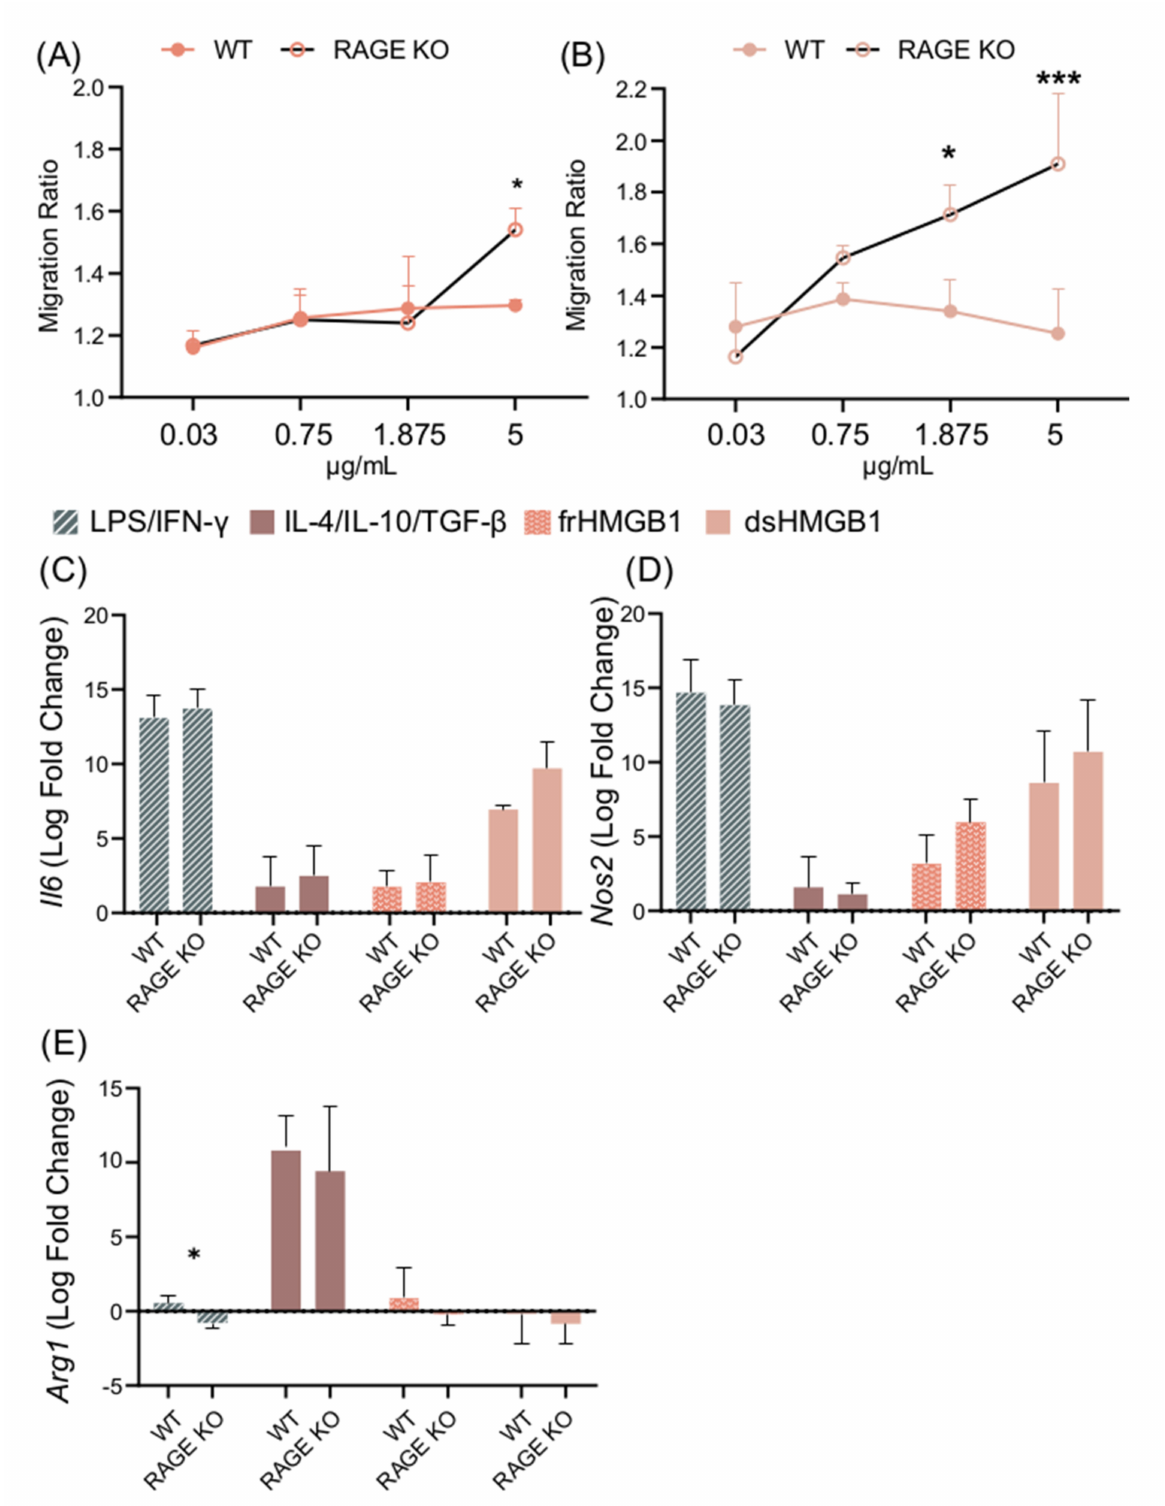
Figure 7. dsHMGB1 induces migration in RAGE KO BMDMs. Migration ratio for a dose titration with ( A ) frHMGB1 and ( B ) dsHMGB1 in RAGE KO and WT BMDMs. Gene expression of ( C ) Il6 , ( D ) Nos2 , and ( E ) Arg1 in WT and RAGE KO BMDMs treated with PBS (negative control), LPS/IFN- γ , IL-4/IL-10/TGF- β , 5 µ g/mL frHMGB1, or 5 µ g/mL dsHMGB1 for 4 h. Data represent n = 3–4 (mean + SD). Statistical analysis was performed using ( A ) a two-way ANOVA with Sidak’s multiple comparisons or ( C – E ) a Welch’s t -test. * p ≤ 0.05, *** p ≤